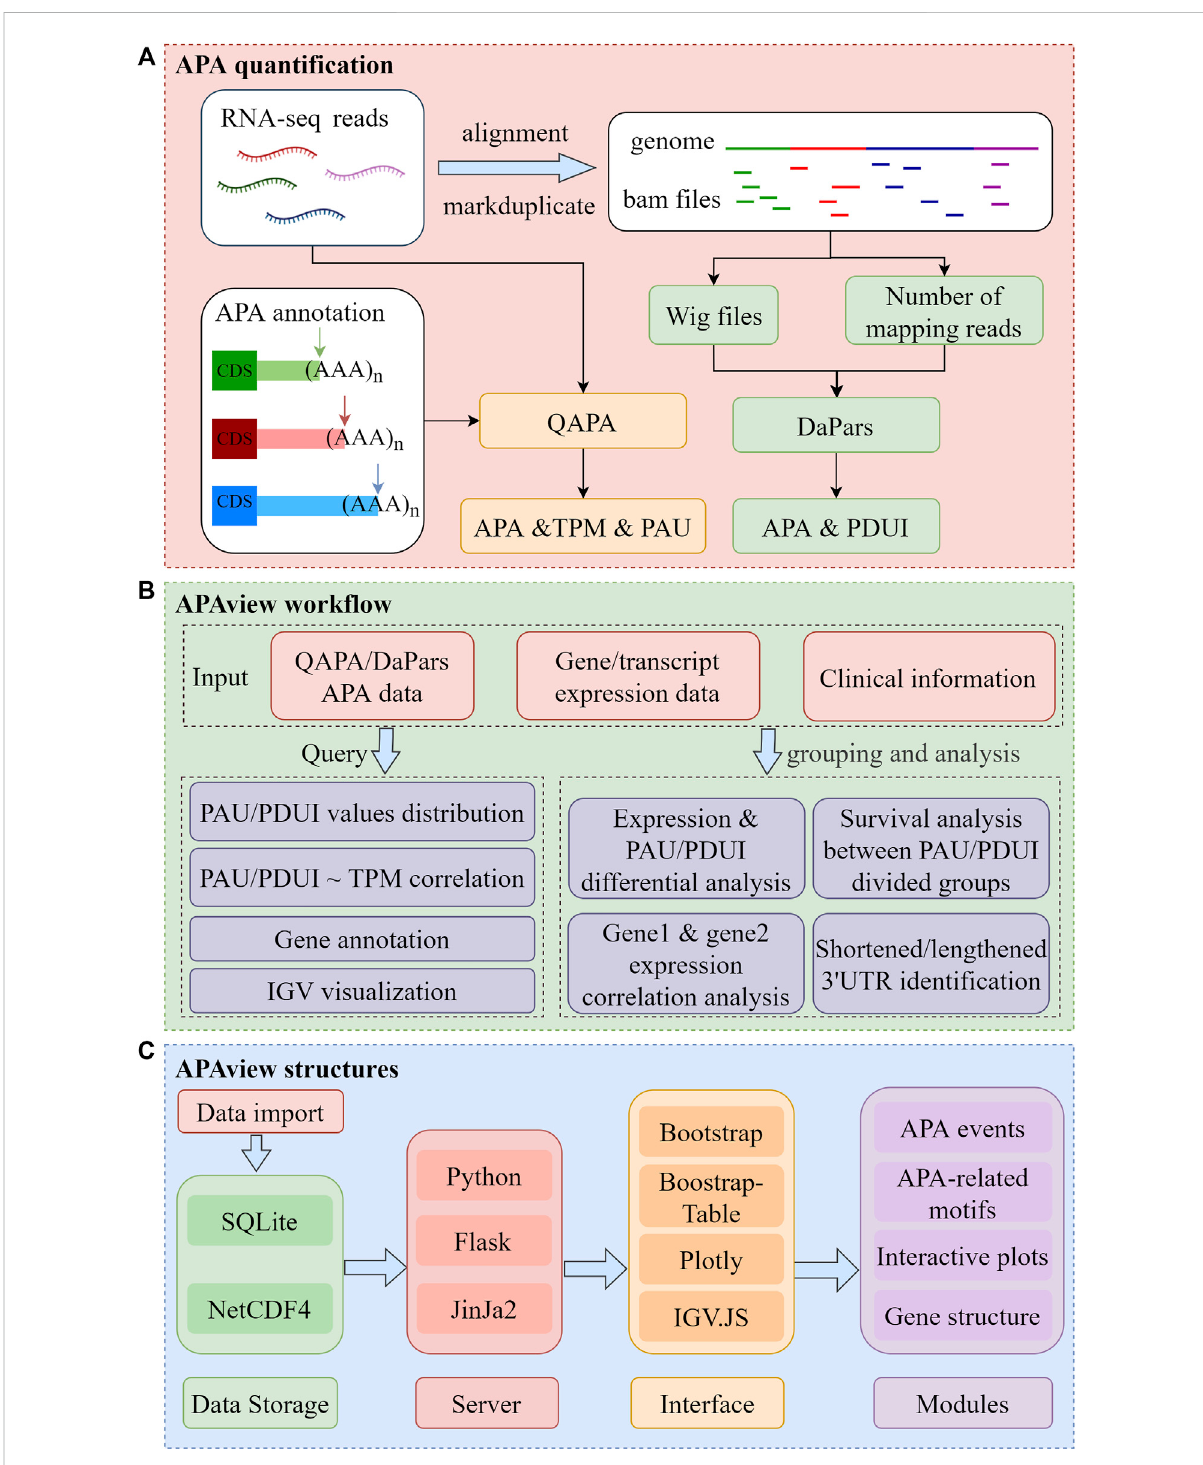
FIGURE 1 Flow chart of APAview. (A) Data preprocessing for APA quanti fi cation. Taking QAPA and DaPars as examples, APA quanti fi cation processes taking RNA sequencing raw data as input are shown. QAPA uses APA site annotation in PolyA site and GENCODE to construct transcripts 3 ′ UTR and calculate TPM and PAU. DaPars takes wig fi les produced after alignment as input, normalizes library sizes using the number of mapping reads, and calculatesPDUI foreachgene. (B) Queryandfunctionalanalysis ofAPA.TakingAPAquanti fi cation,gene/transcriptexpression,andclinicaldata as input, APAview provides APA query and visualization in the Query module. In the Analysis module, APAview achieves correlation analysis, survival analysis, differential analysis, and lengthening/shortening gene identi fi cation. Features between user-de fi ned groups can be compared. (C) Storage and display structures of APAview. APAview stores data in SQLite and NetCDF4 fi les. Python, Flask, and Jinja2 are used to build the interactive web platform. APA data are shown as tables using Bootstrap-Table; analysis results are shown using Plotly; gene structure and APA-related motifs are shown using IGV. JS. PAU, PolyA site usage; PDUI, percentage of distal PolyA site usage index; TPM, transcripts per kilobase